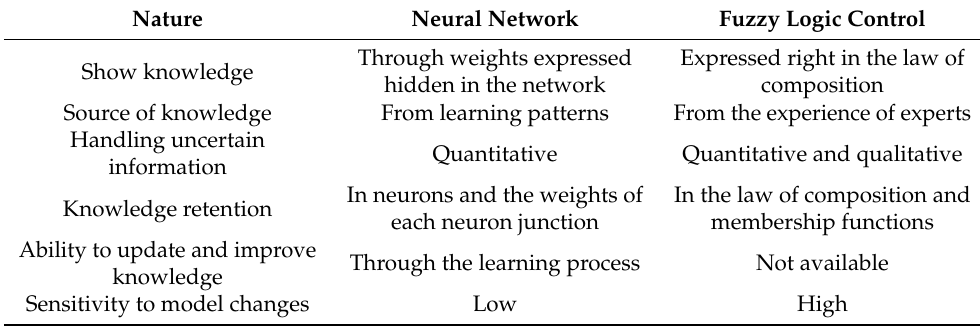
Table 1. Advantages and disadvantages of neural networks and fuzzy control.